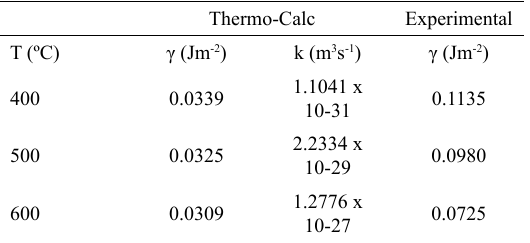
Table 2. Thermo-Calc calculated interfacial energy between precipitate and matrix and coarsening constant, and experimental interfacial energy for aging temperatures Thermo-Calc Experimental